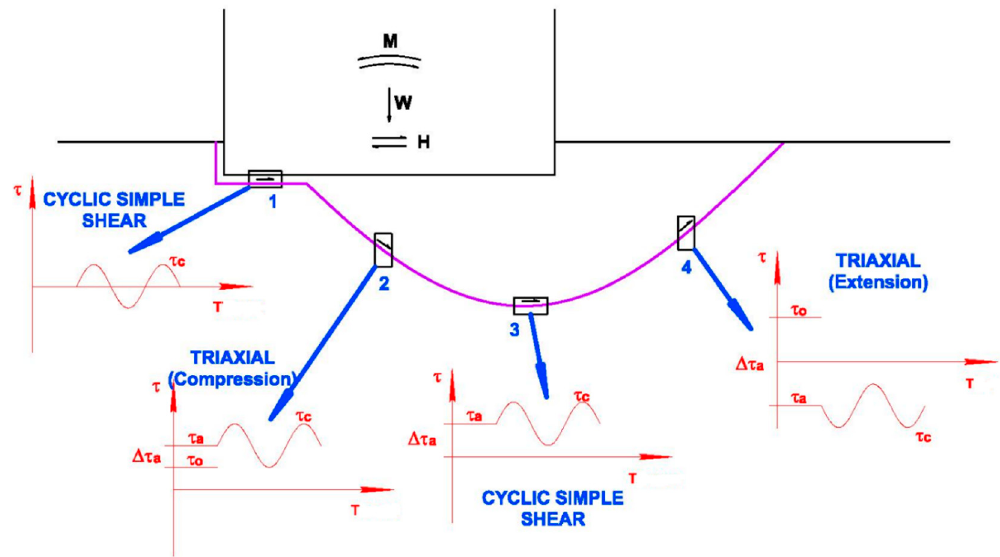
Figure 1. Scheme that idealizes the stress conditions that occur along a hypothetical failure surface and that can be simulated by simple cyclic shear tests and triaxial tests.